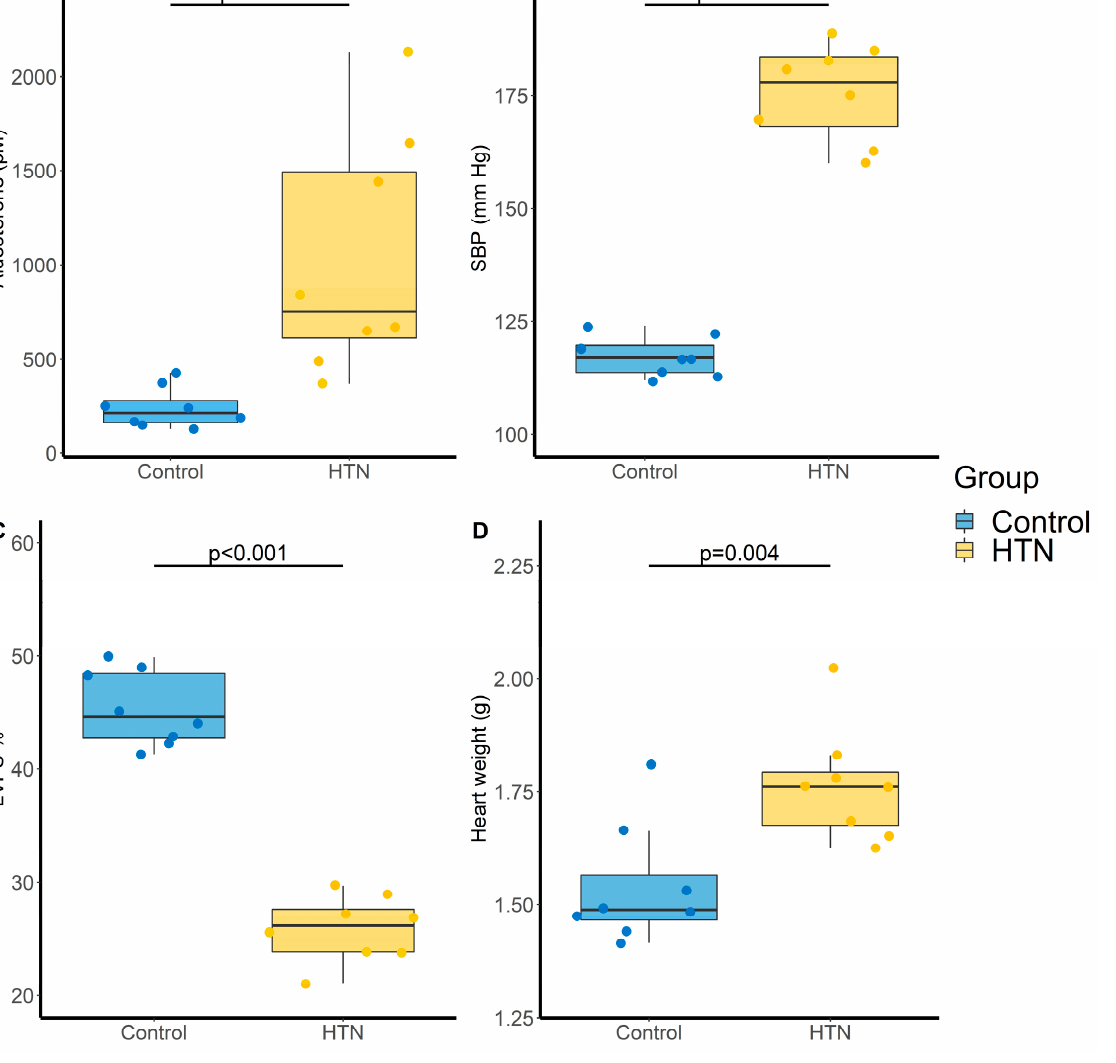
Figure 2. Evaluation of cardiovascular parameters in control and hypertensive (HTN) rats. ( A ) Aldosterone levels (pM); ( B ) Systolic blood pressure (SBP, mm Hg); ( C ) Left ventricular fractional shortening (LVFS, %) and ( D ) Heart weight (g). N = 8 for each group. p -values computed by Student’s t -test.